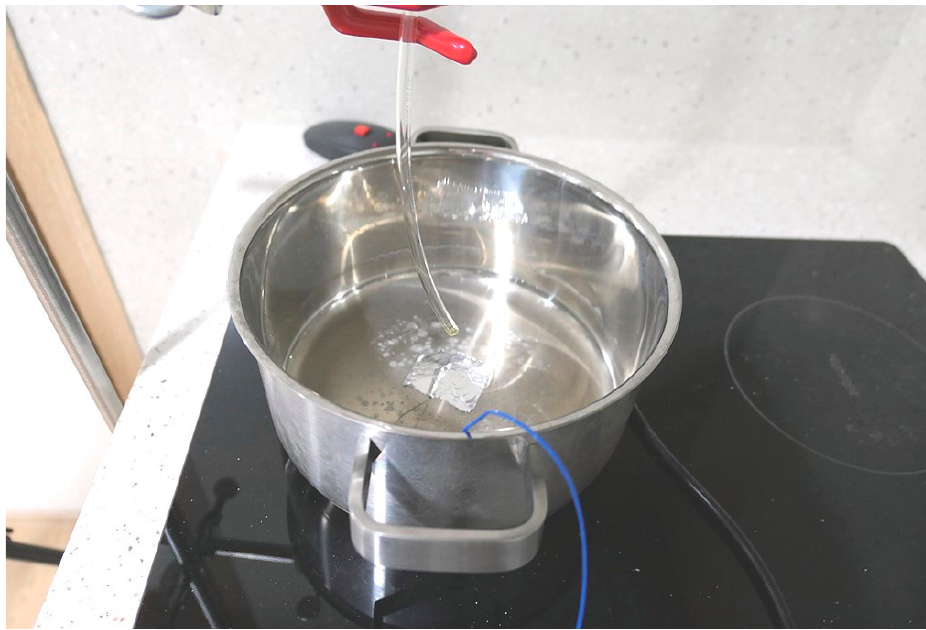
Figure 3. CO 2 injection to the round-shaped pot.